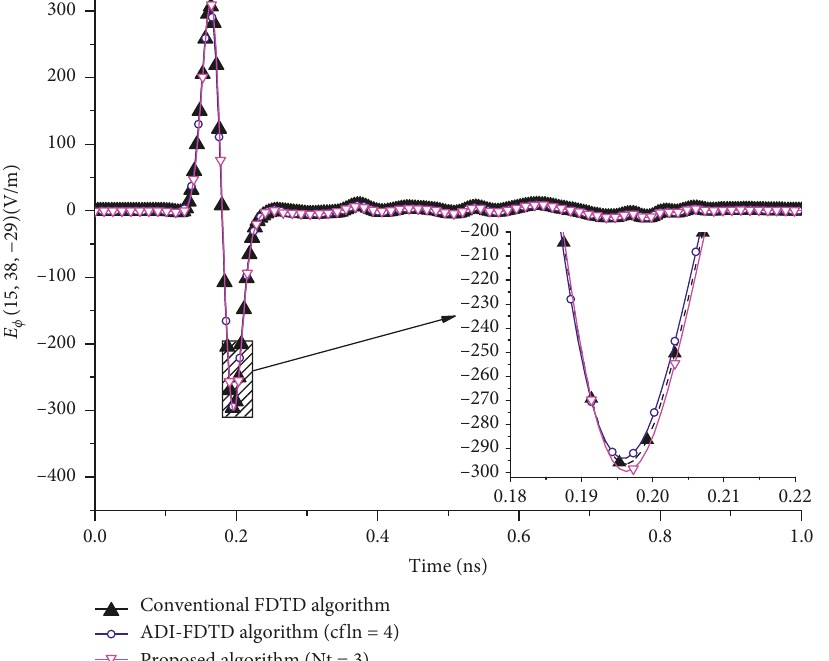
Figure 14: Computational results of E algorithm.